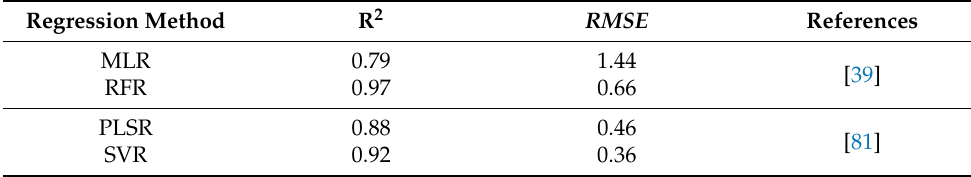
Table 5. Comparison of results of different regression